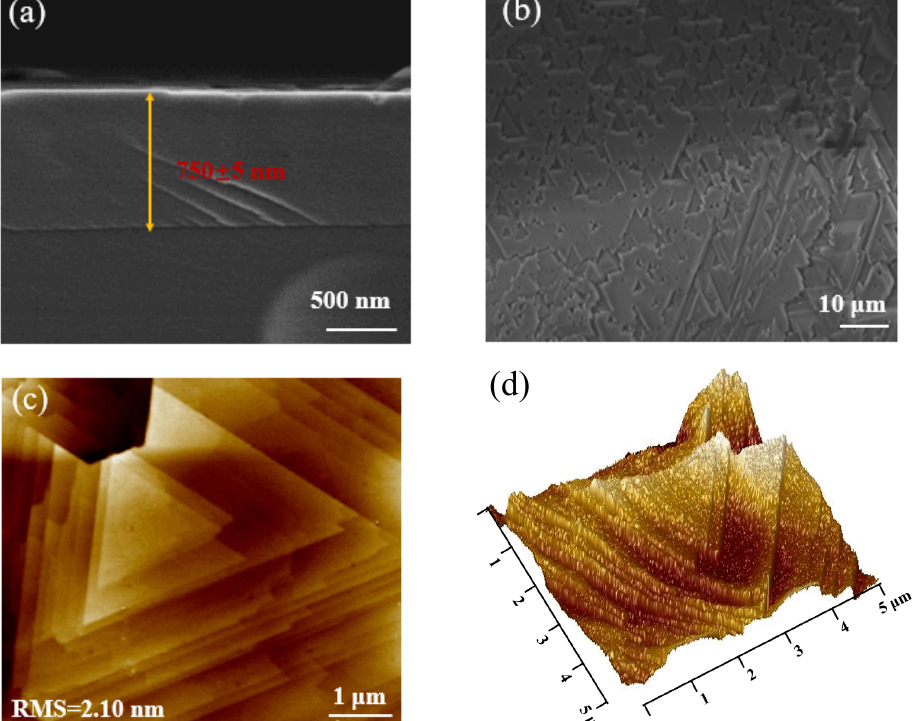
Figure 3. The cross-sectional SEM image of β -(Al x Ga 1 − x ) 2 O 3 film grown on sapphire substrate ( a ). Corresponding surface SEM image ( b ) and 2D ( c ) and 3D ( d ) AFM images.